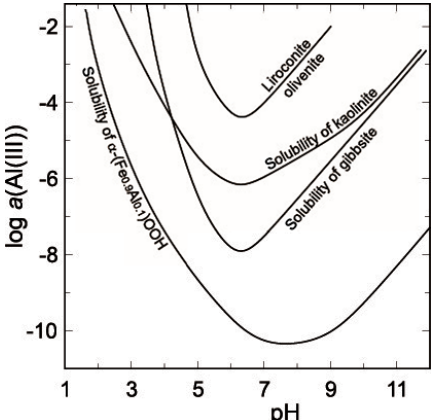
Figure 6. Solubilities of some common Al − Fe minerals, com- pared to the Al(III) concentrations needed to stabilize liroconite. All curves are calculated by PHREEQC (Parkhurst and Appelo, 1999). The curve for olivenite–liroconite was calculated by forcing a fluid to be in equilibrium with both phases